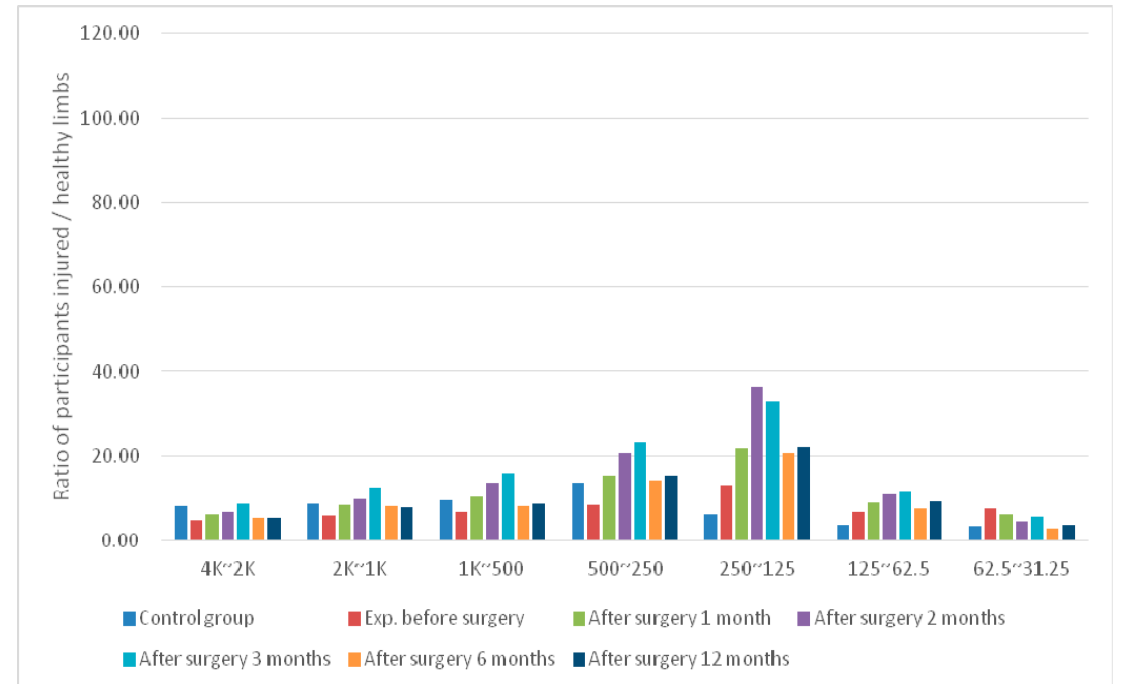
Figure 4. Average differences in signal bands at the ACL sensing point of postoperative knees in the experimental group.